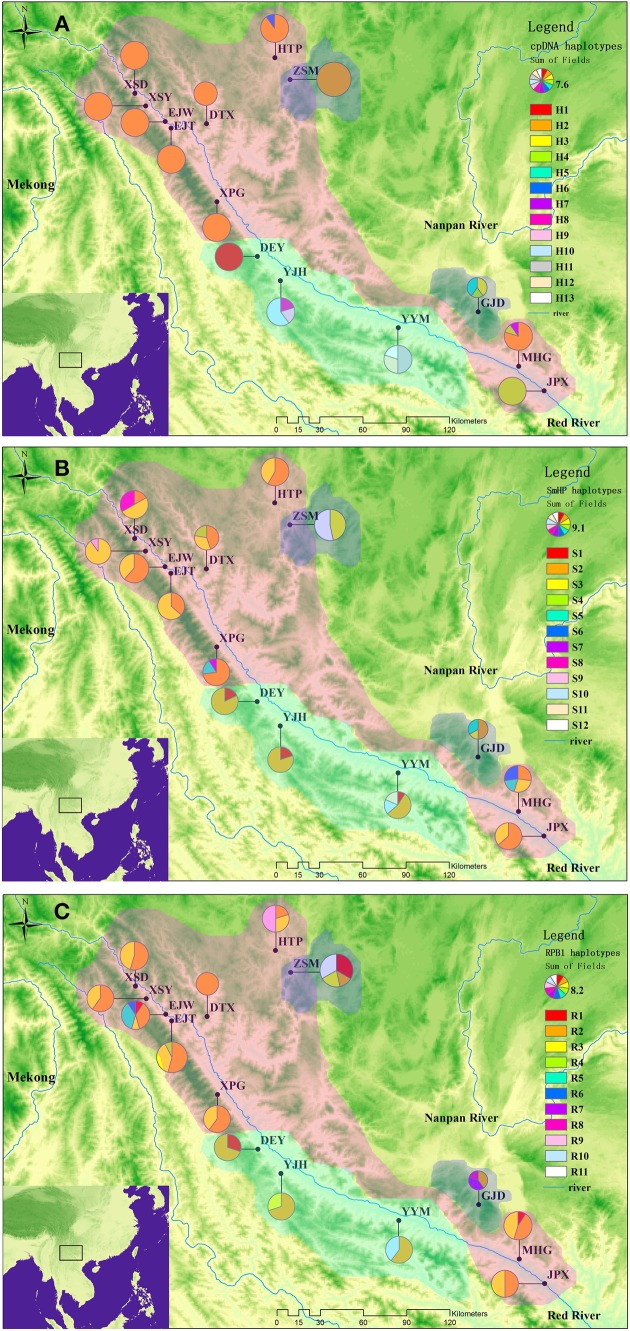
Geographical distributions of cpDNA haplotypes (A), nDNA SmHP haplotypes (B), nDNA RPB1 haplotypes (C) in C. diannanensis. Frequencies of haplotypes in each population are indicated by the proportions of pie diagrams. The colored dash areas present the sampling and possible distributions of the Cycas species in this study: Red, C. diannanensis; Green, C. parvula; Blue, C. multiovula.